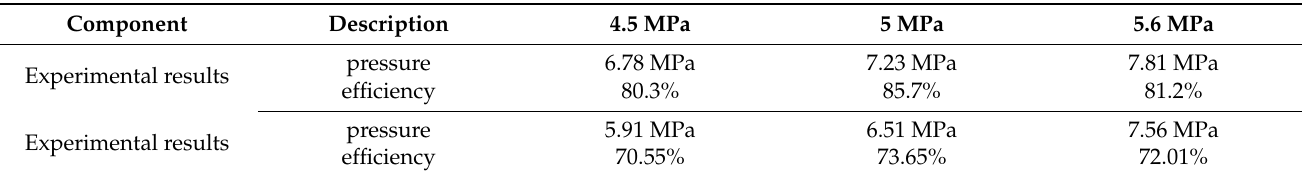
Table 3. Final pressure and energy recovery efficiency rates of the accumulator at various initial pressures.